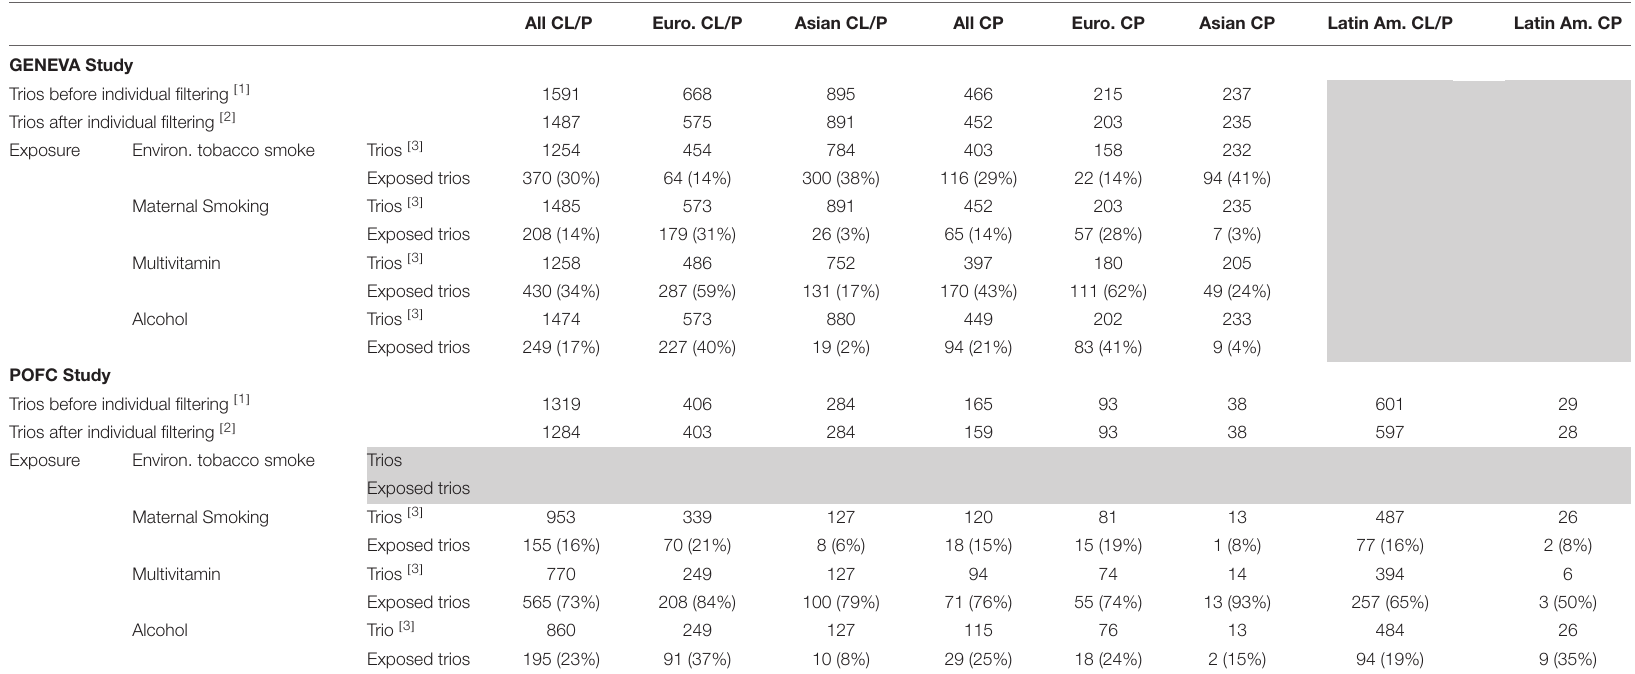
TABLE 1 | Number of case–parent trios in the GENEVA and the POFC studies stratified by type of cleft (CL/P and CP) and racial/ethnic group (European, Asian, and Latin American). All CL/P Euro.